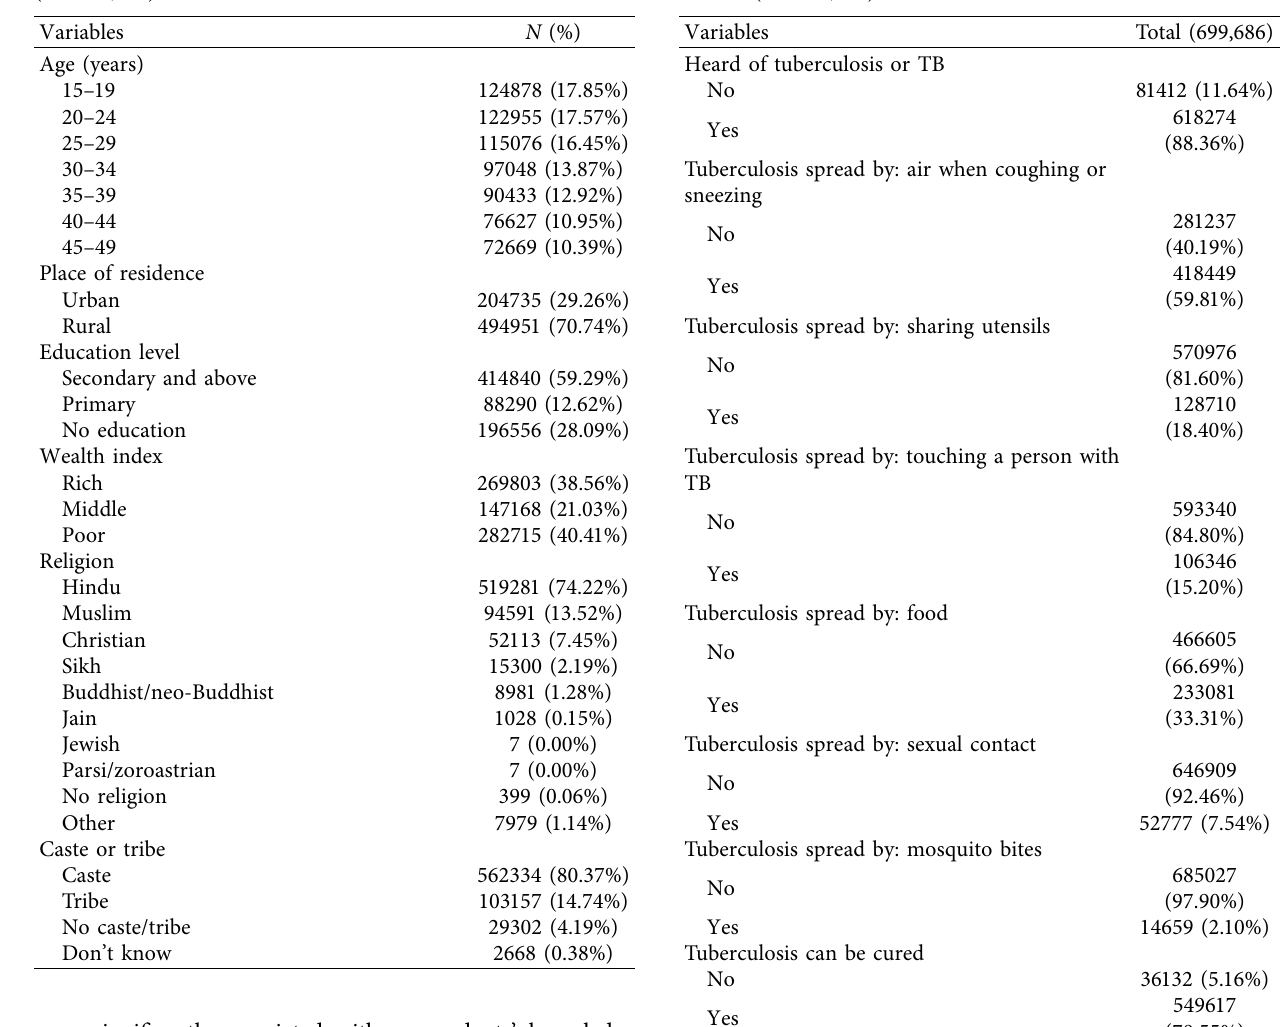
Table 1: Demographic characteristics of the study participants Table 2: Knowledge and attitude towards tuberculosis